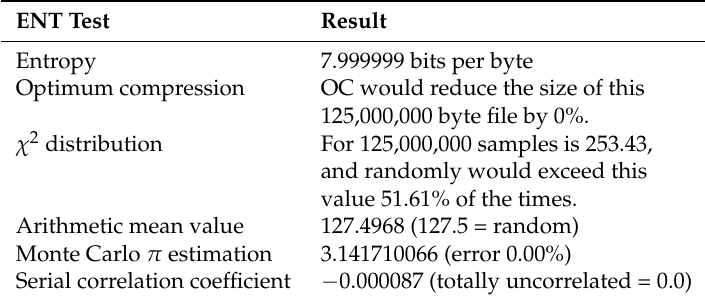
Table 3. ENT statistical test